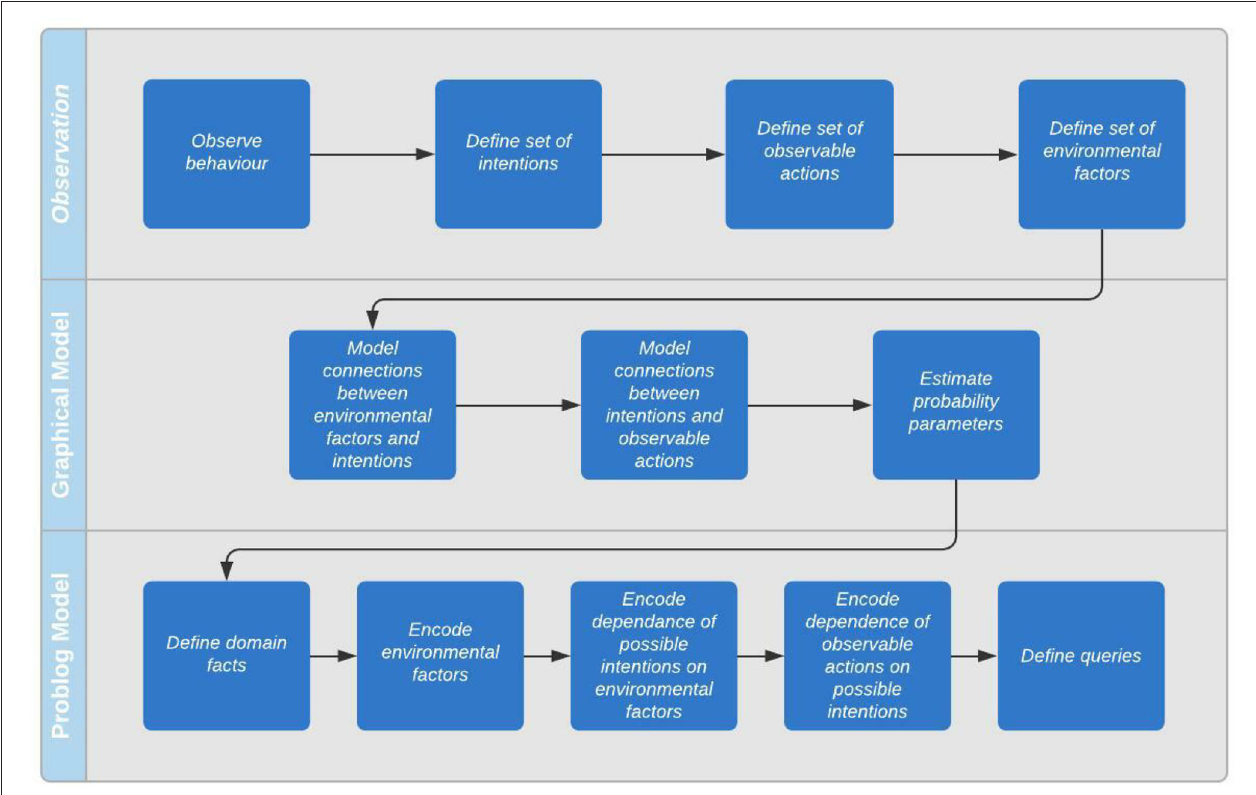
FIGURE 3 | Model development process.